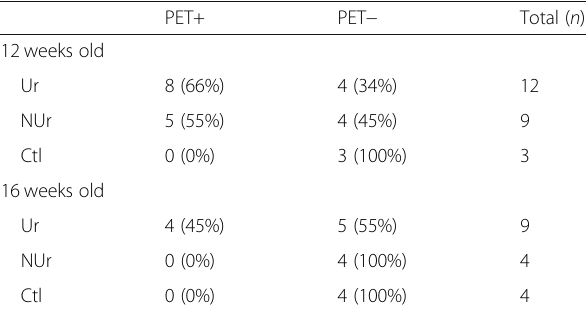
Table 1 Contingency table for PET in detecting [18F]NaF aortic uptake